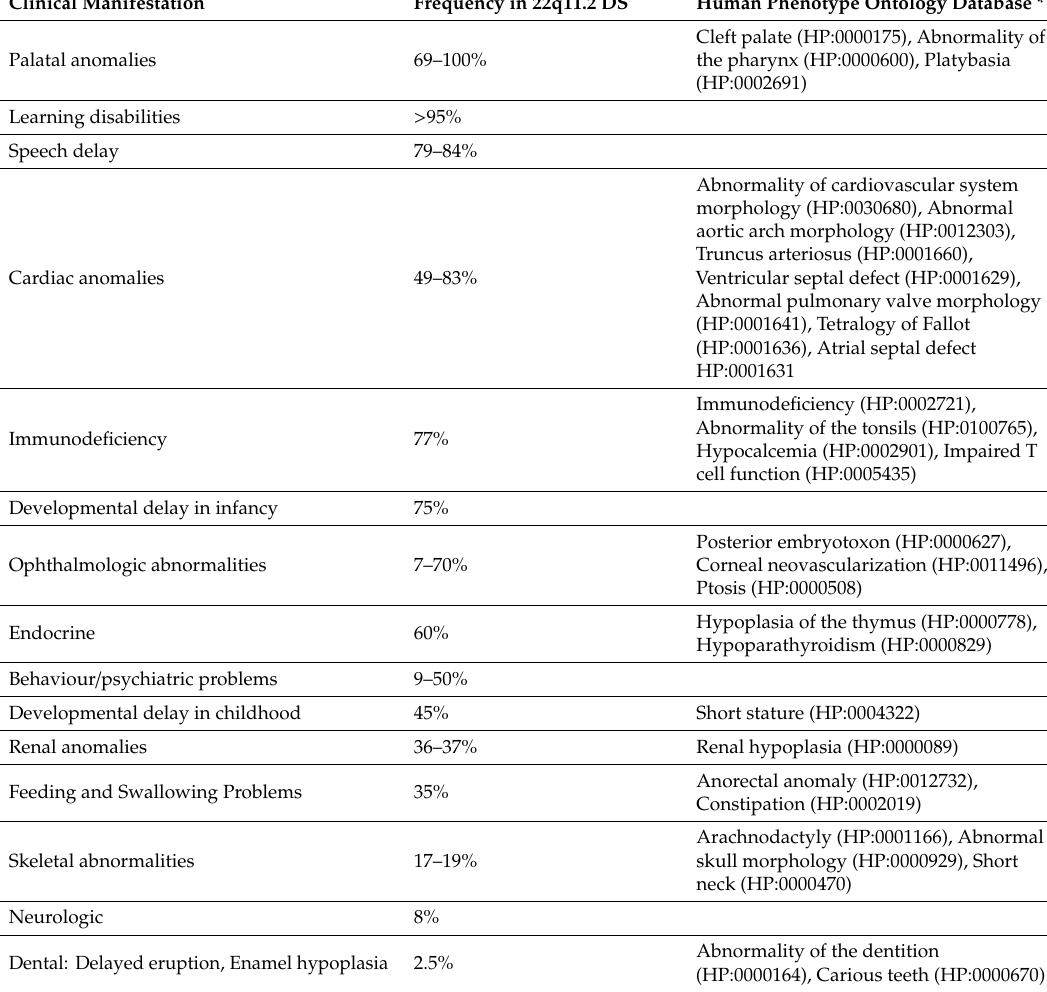
Table 2. Selected clinical manifestation in patients with chromosome 22q11.2 deletion syndrome [5,23,61]. Clinical Manifestation Frequency in 22q11.2 DS Human Phenotype Ontology Database